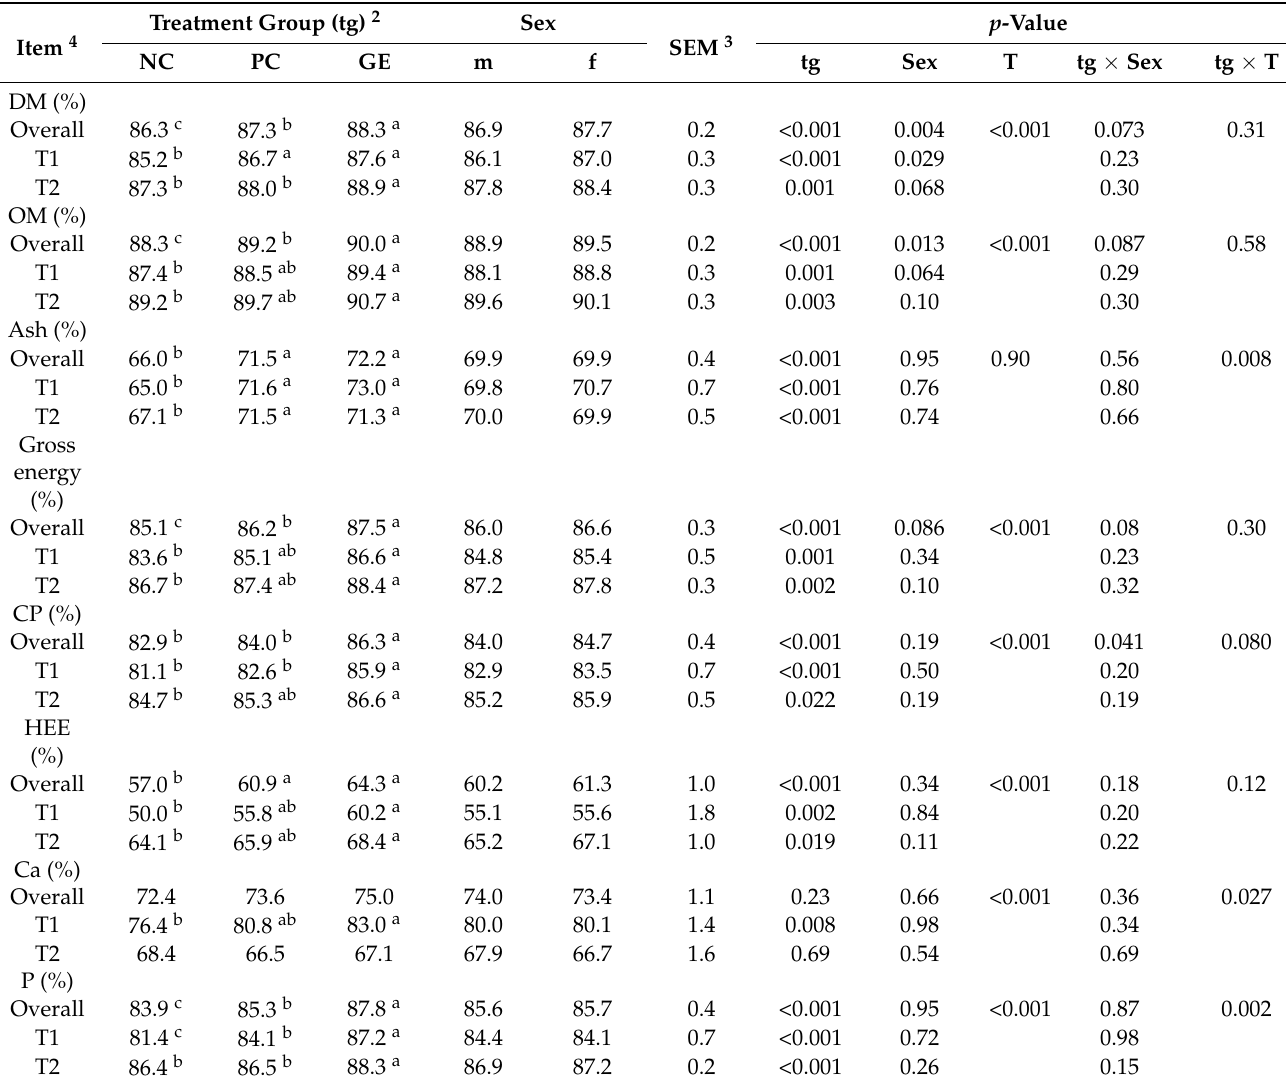
Table 4. Effect of using NC and PC for testing dietary GE supplementation on apparent total tract digestibility of weaning piglets 1